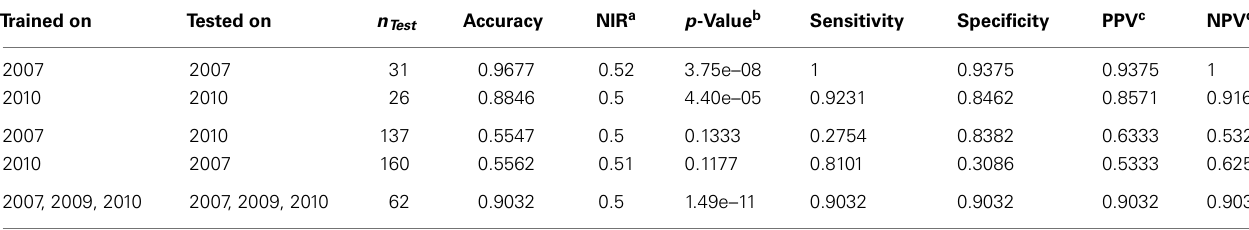
Table 3 | Results of the support vector machines, trained and tested on different subsets of all samples . Trained